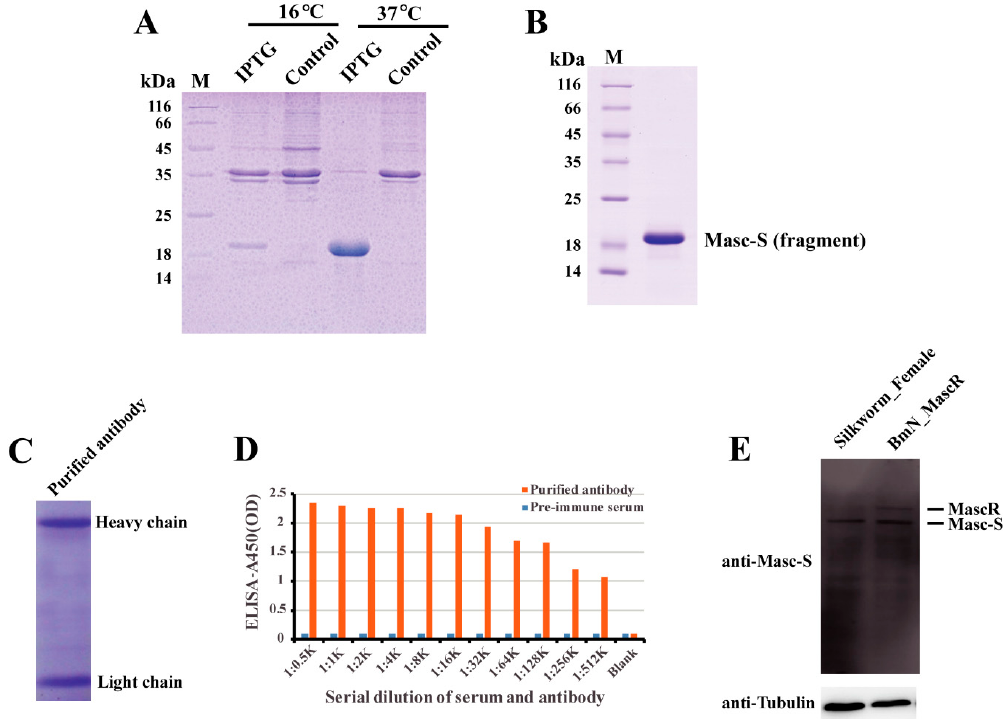
Figure 3. Preparation of polyclonal antibody and detection of the Masc-S protein in the female silkworm. ( A ) Analysis of the recombinant Masc-S (fragment) protein in E. coli Transetta(DE3) by SDS-PAGE. Lane M: Protein marker, lane IPTG: E. coli Transetta containing pET-28a-Masc-S(fragment)-His was induced with IPTG, lane control represents the control. ( B ) Purification of the recombinant Masc-S (fragment) protein. Lane M: Protein marker. ( C ) Analysis of purified polyclonal antibody of Masc-S by SDS-PAGE. ( D ) Titer analysis of Masc-S antibody by ELISA. The Masc-S antibody titer was more than 1:512000. Purified antibody starting dilution: 1:500. Optical density (OD) was detected via a microplate reader at 450 nm. ( E ) Detection of the Masc-S protein in the female silkworm and cell line by Western blot. Lane Silkworm_Female represents nucleoprotein extract from the female silkworm. lane BmN_MascR represents nucleoprotein extract from the cell line BmN in which MascR were over-expressed. α -Tubulin was used for the internal control.